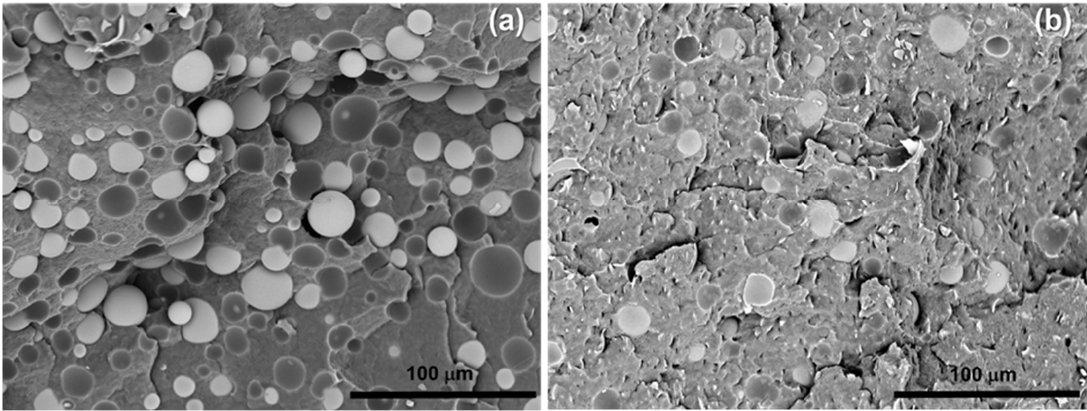
Figure 1. SEM image (magnification 600×) of PCL–HGM20 ( a ) and PCL–HGMf20 ( b ).